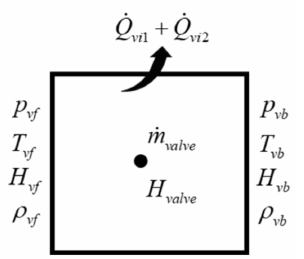
Figure 5. Schematic diagram of regulating valve control